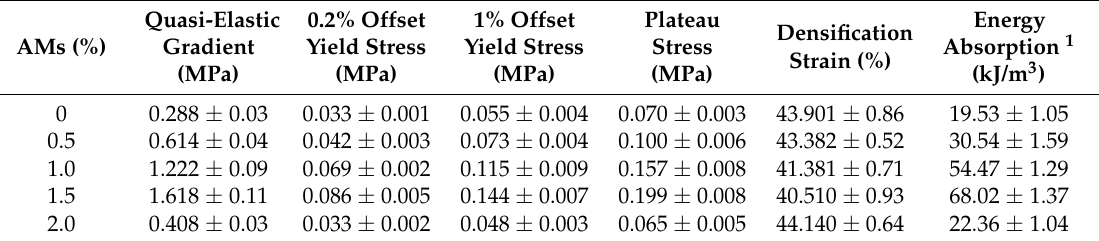
Table 2. The main compressive mechanical properties of investigated semi-rigid PU foams.